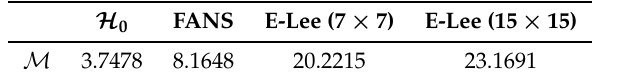
Figure 2. Examples of ratio images after filtering the observed data ( top ) with two despeckling filters. The ideal ratio image is also shown ( top right ). The filtered image by the enhanced Lee filter (7 mask size) is shown in the second row ( left ) and the ratio image in the same row ( right ). The filtered image by the FANS filter is shown in the third row ( left ) and the ratio image in the same row ( right ). estimator for the examples shown in Figures 2 and Table 1. M